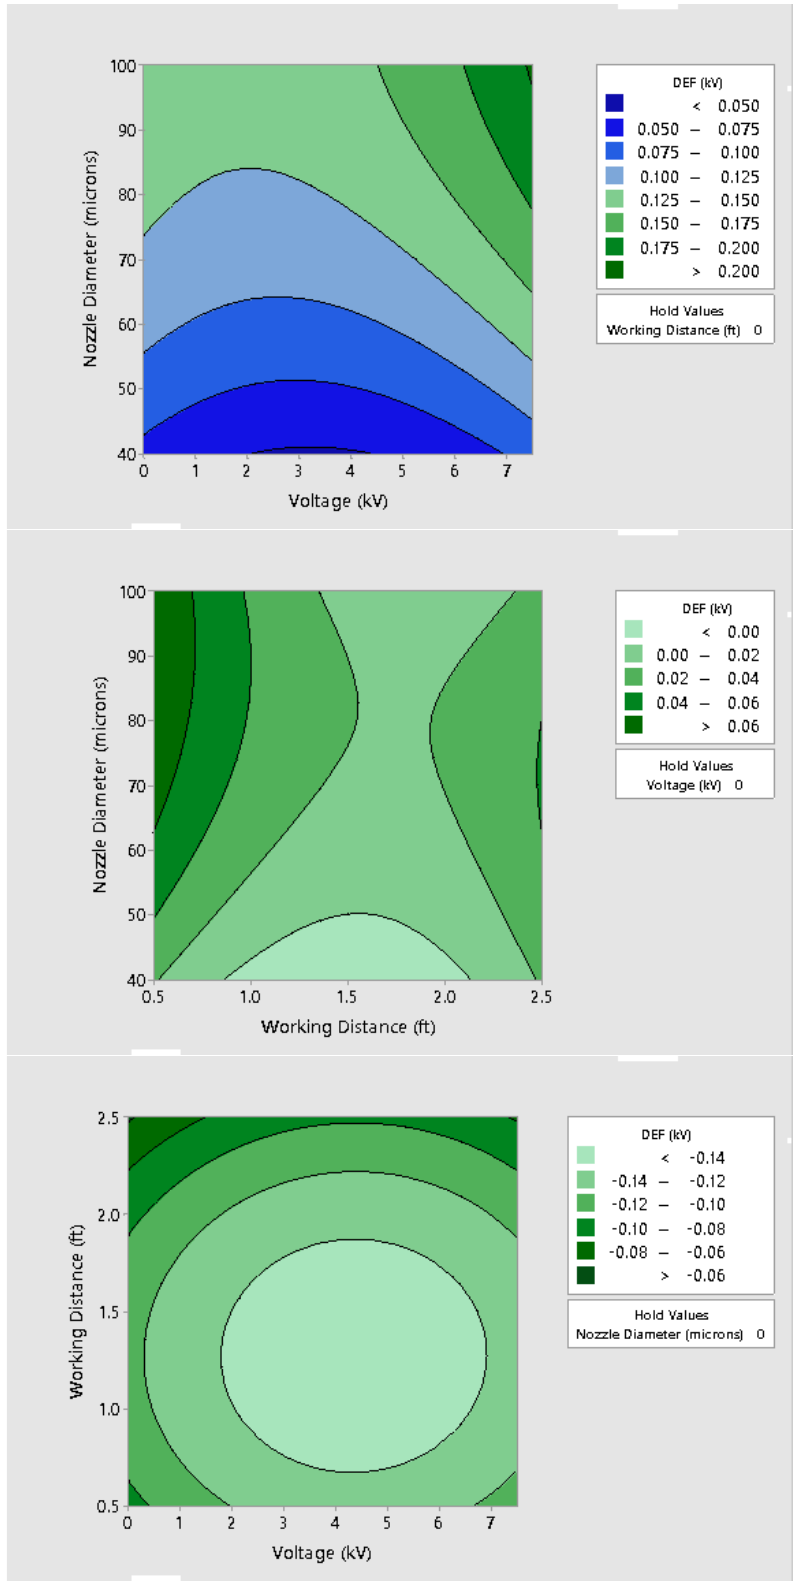
Figure A12. Copper: quantitative representation of average differential electric field vs. working distance (feet), nozzle sprayer size ( µ m), and charge voltage